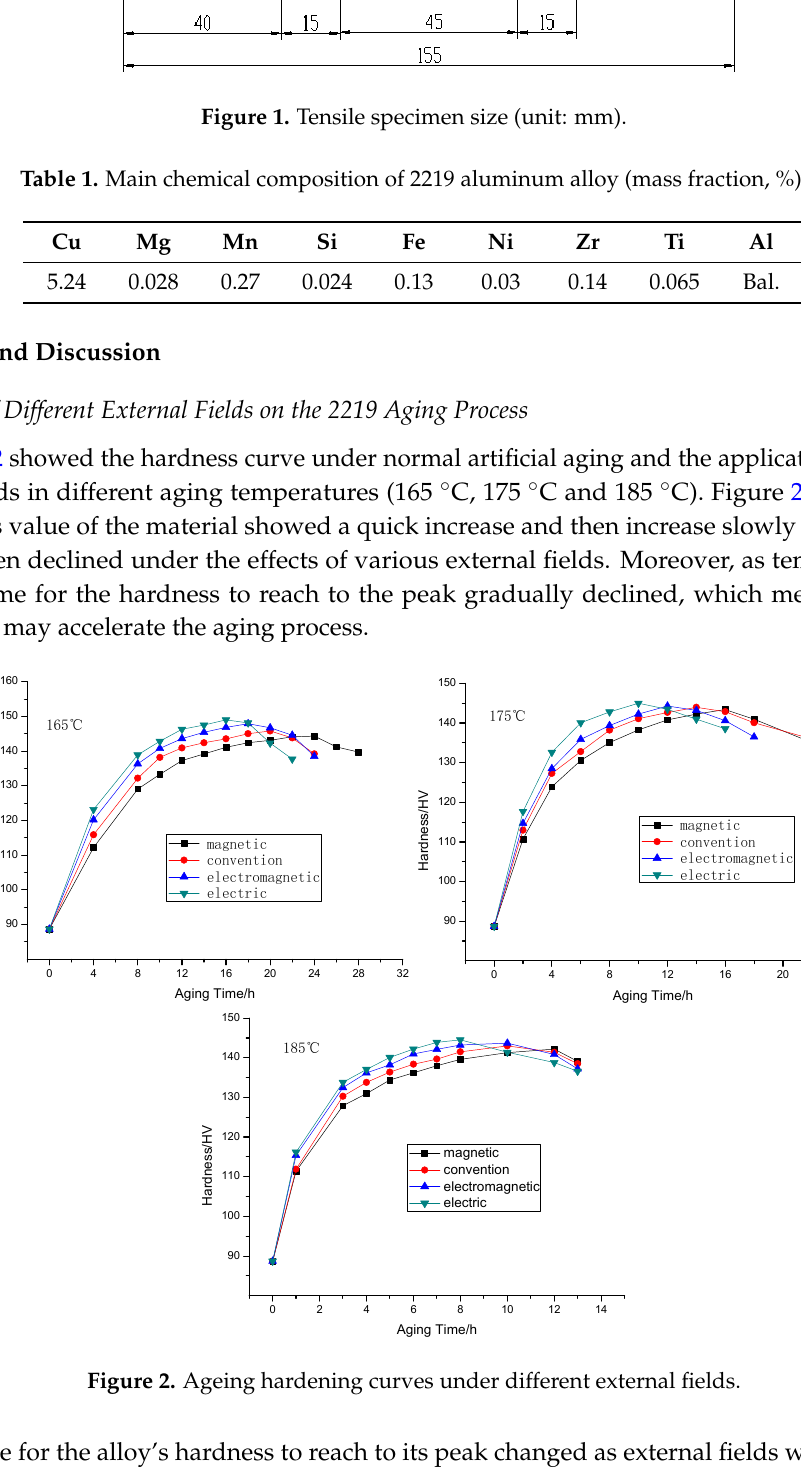
Figure 2. Ageing hardening curves under different external fields.